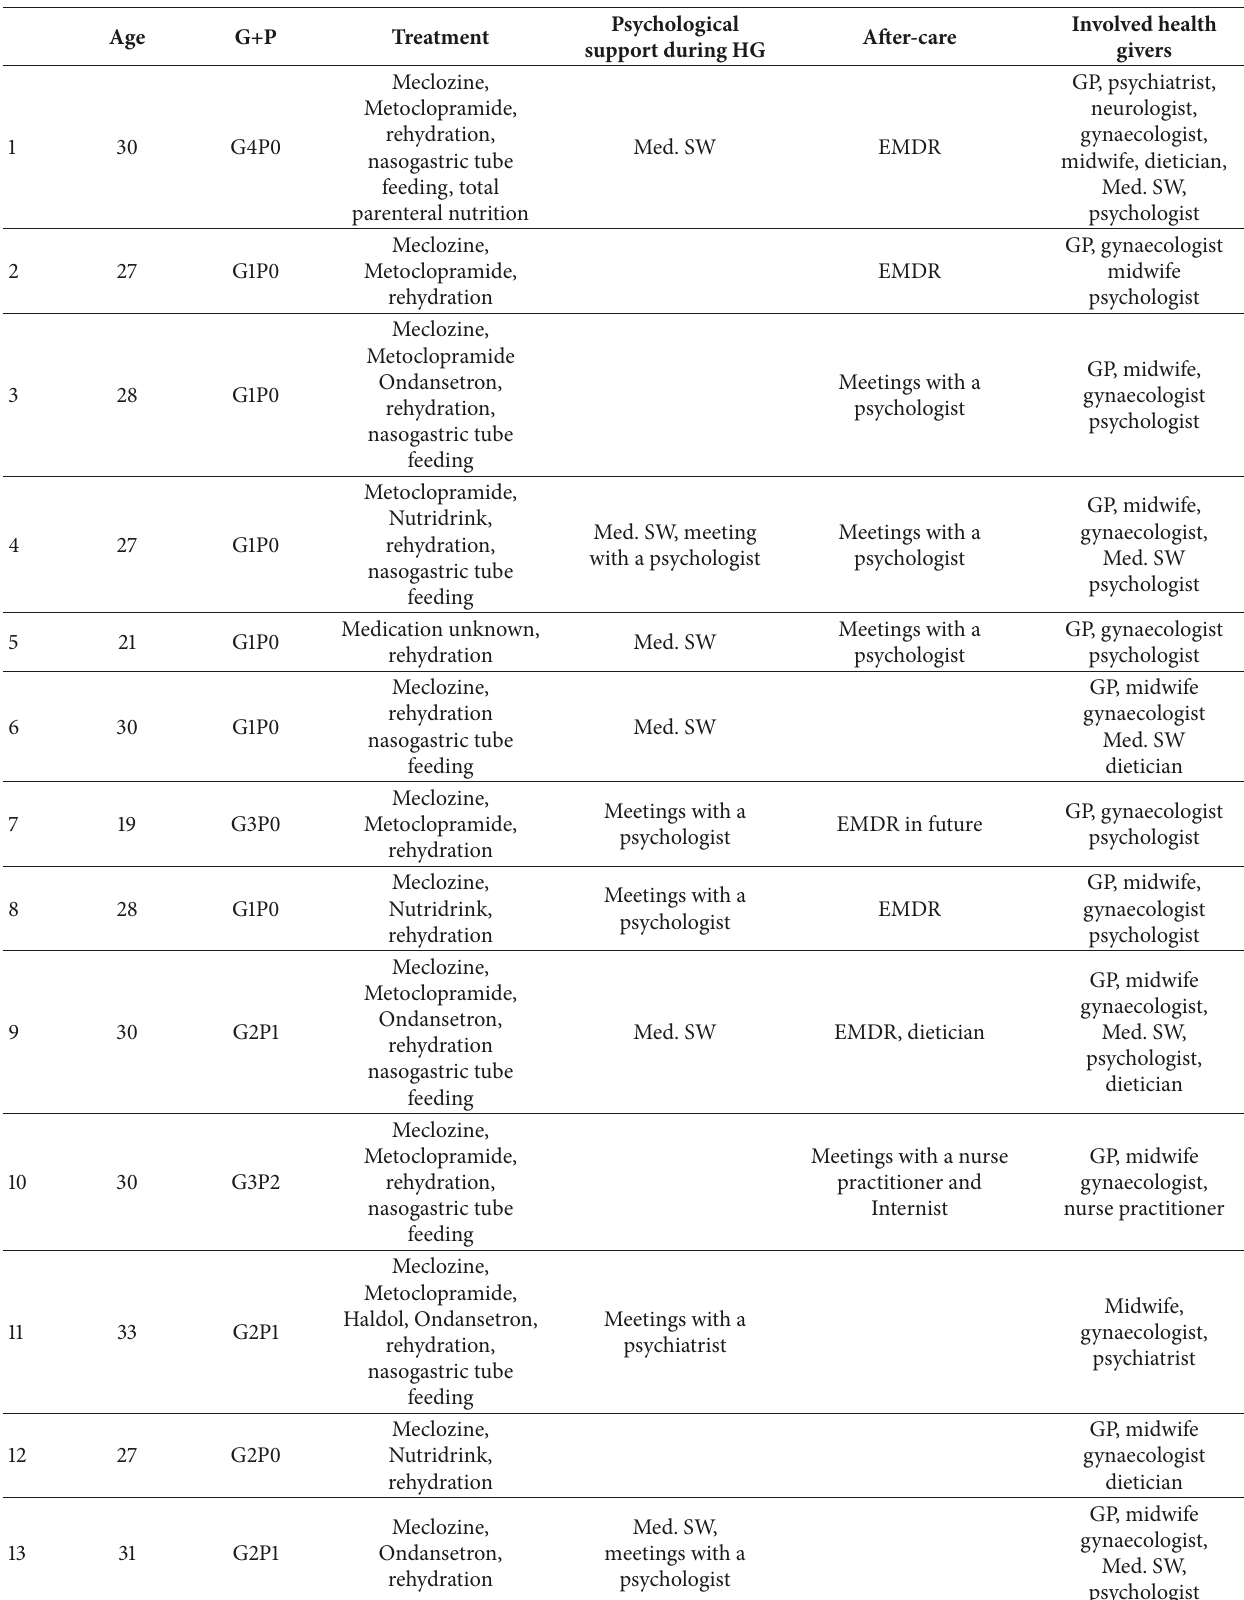
Table 1: Baseline data of the women interviewed regarding their hyperemesis gravidarum experiences.